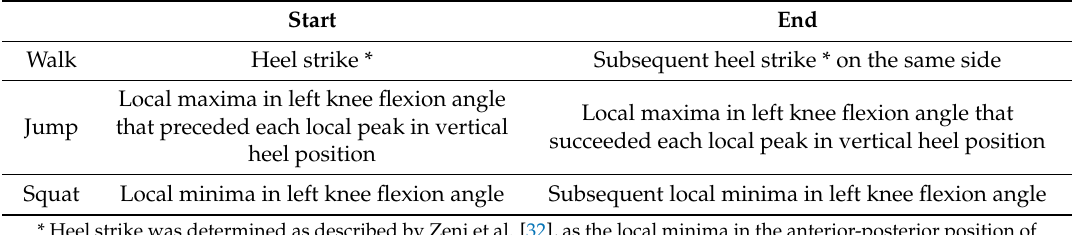
Table 1. Definition of start and end of movement cycles for each